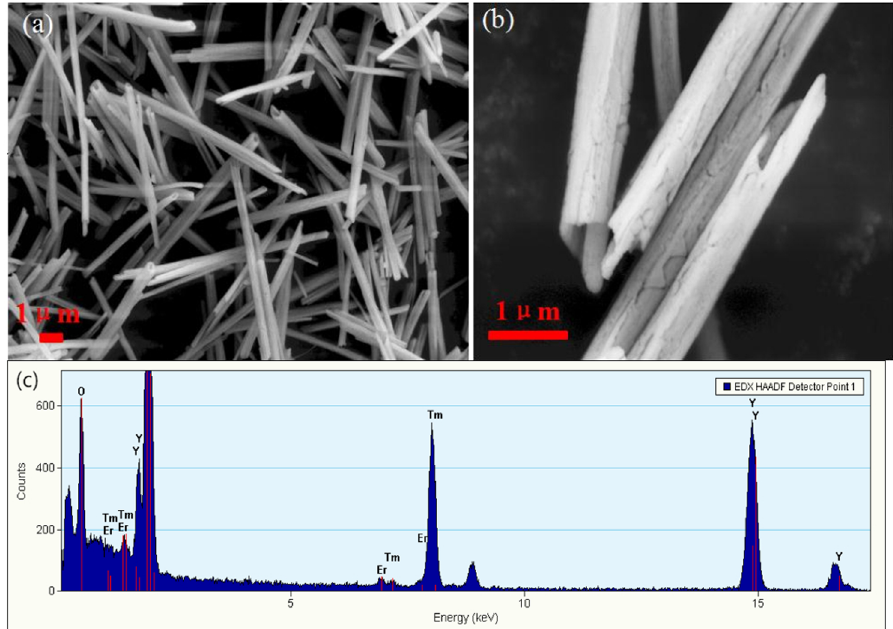
Figure 1. ( a ) SEM image, ( b ) enlarged SEM image, and ( c ) EDS spectrum of Y 2 O 3 :1%Er 3 + , 1.5%Tm 3 +